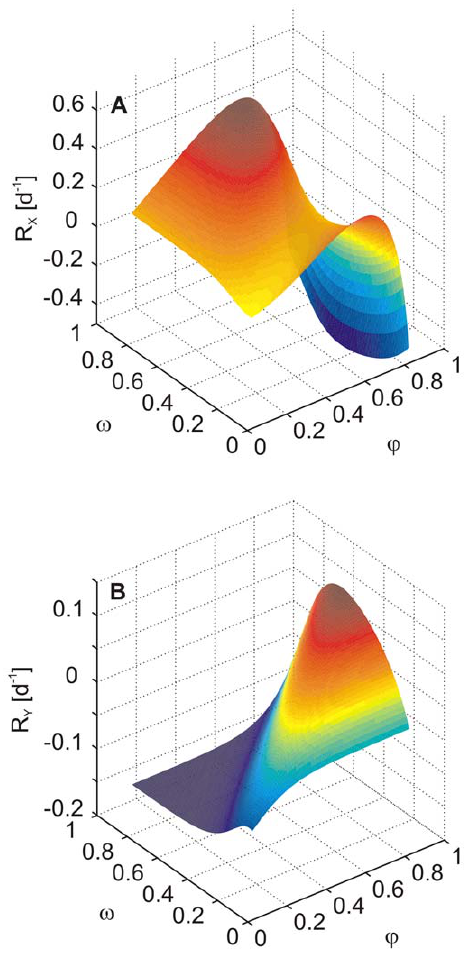
Figure 2. Specific net growth rates of prey and predator. ( A ) prey ( R X , cf. Eq. (10)) and ( B ) predator ( R Y , cf. Eq. (11)) in dependence of Q and v . Values of the mean trait values during a standard run are 0 : 3 v Q v 0 : 7 and 0 : 25 v v v 0 : 36 . Parameters as in Table 1, prey biomass=3 g C m { 2 , predator biomass=1 g C m { 2 .